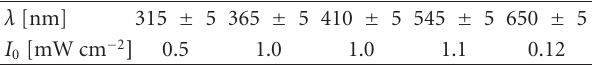
Table 2: Incident light intensities I 0 at di ff erent wavelengths.